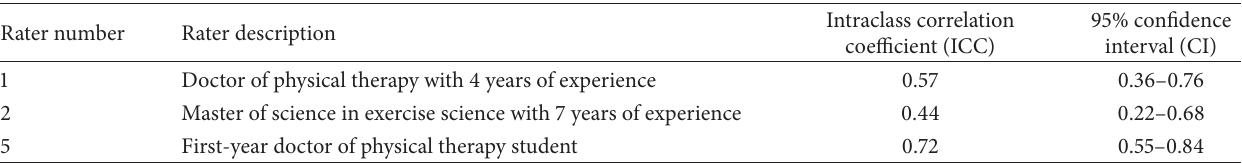
Table 2: Intrarater reliability ICC and 95% CI for each rater of